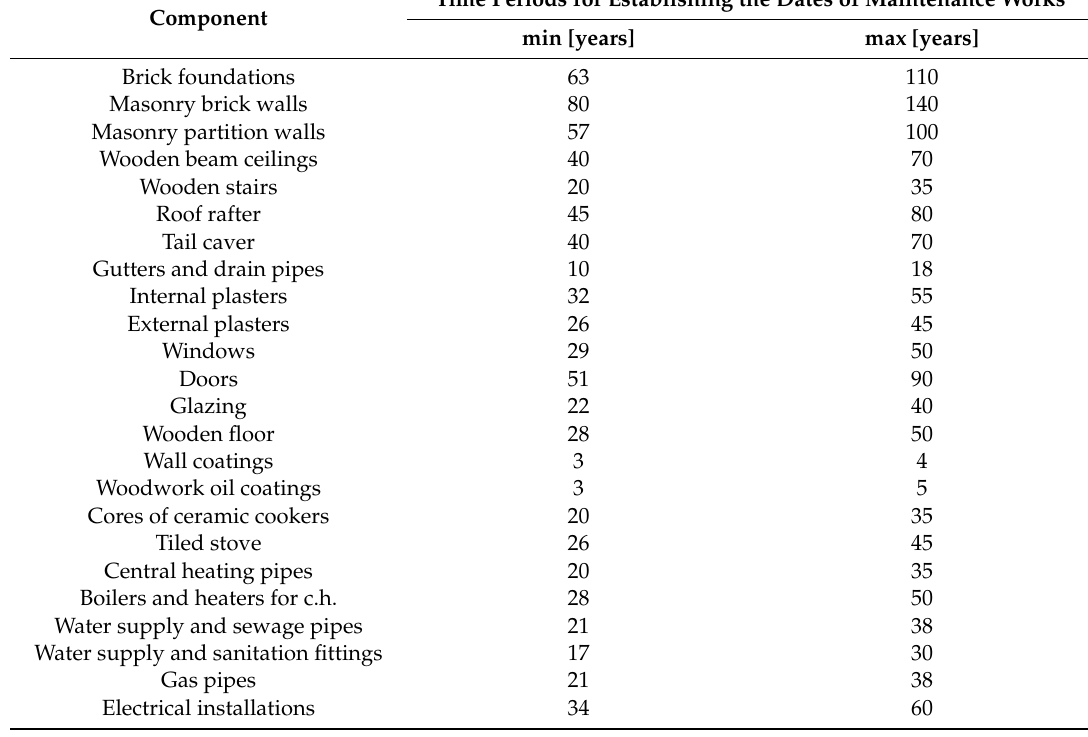
Periods of durability of individual building components from selected building materials